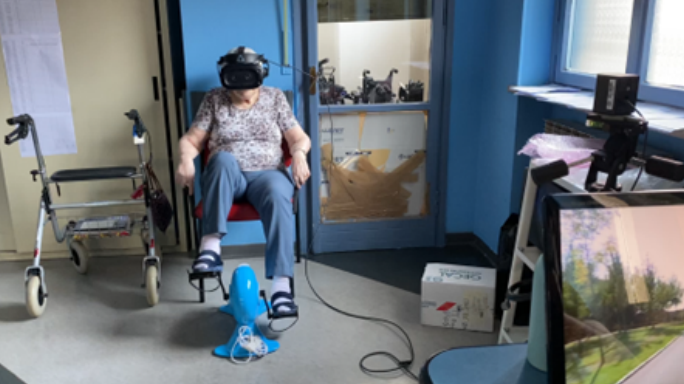
Figure 2. A photograph of a virtual biking session. Used with